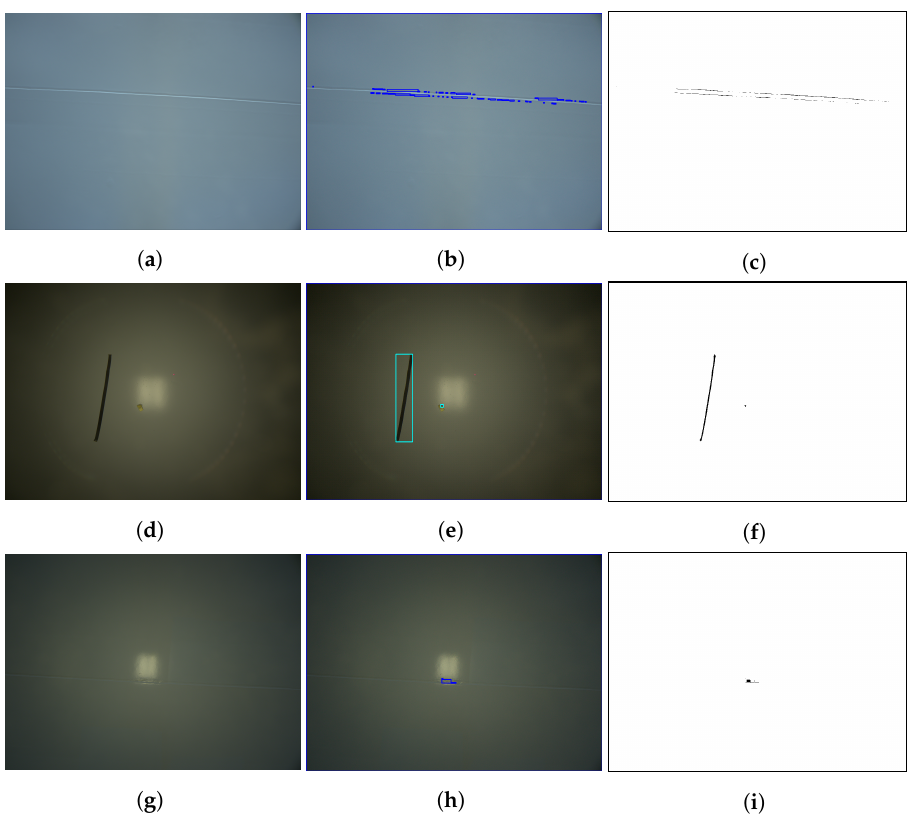
Figure 8. RGB images of part of the bridge under different weather conditions: sunny ( a ), night ( d ) and wet ( g ). Processed images by the flaw detection algorithm ( b , e , h ) show the colored bounding box encapsulates the flaws detected. Detected flaws are highlighted by binary images ( c , f , i ). Figure 9 shows a 2D projection of a 3D image. The result of the flaw detection algorithm plots circular and rectangular bounding boxes that surround the flaws. The algorithm identified defects such as holes, bumps and color variation.